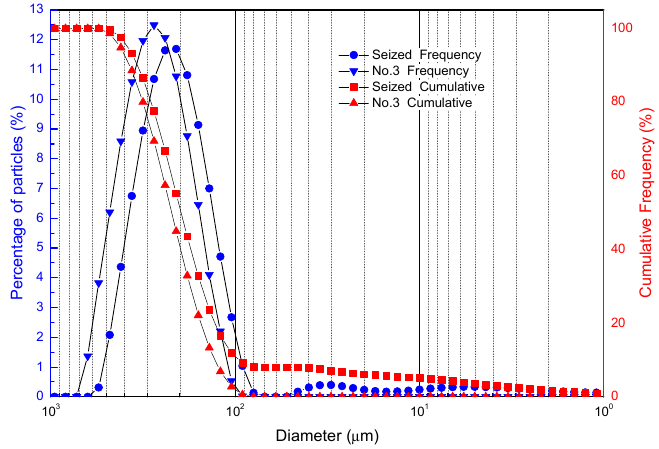
Figure 7. Sizes of the seized sand and sand production in Experiment No. 3.